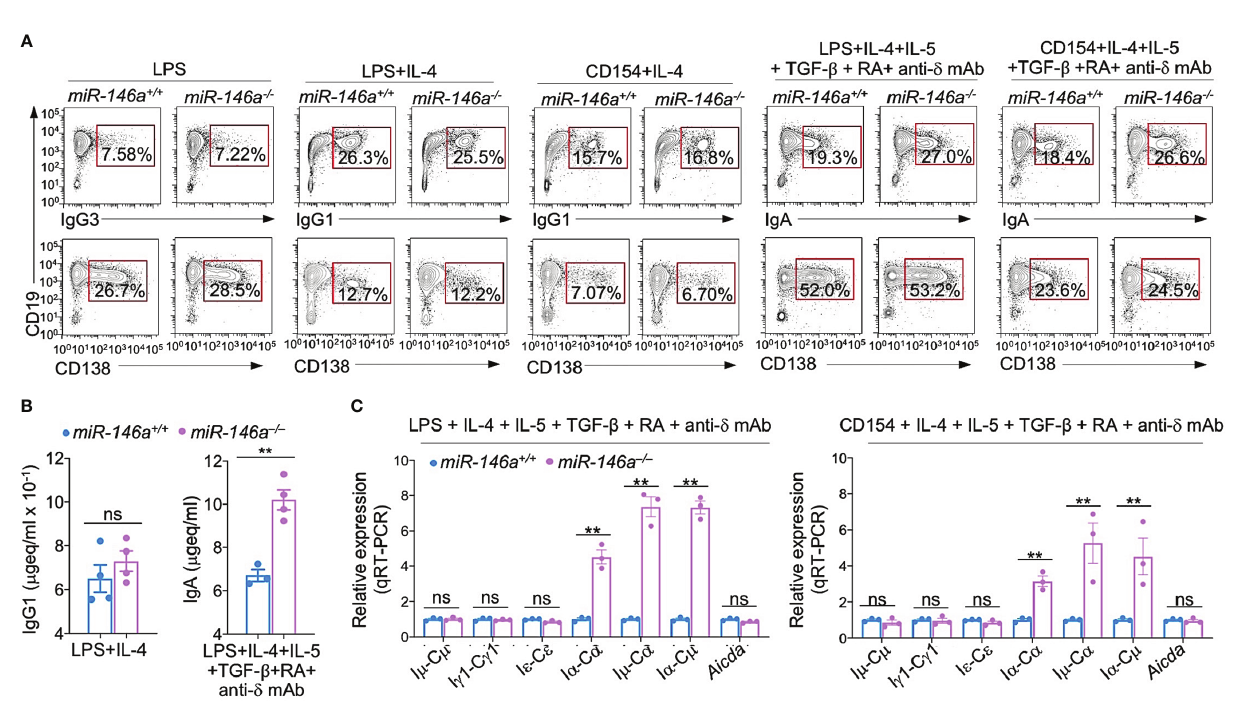
FIGURE 5 | miR-146a ablation results in increased germline I a -C a transcripts and enhanced CSR to IgA . (A) miR-146a – / – and miR-146a +/+ B cells were stimulated with LPS, LPS or CD154 plus IL-4, LPS or CD154 plus IL-4, IL-5, TGF- b , RA and anti- d mAb, and cultured for 96 h. IgG1 + , IgG3 + and IgA + B cells and CD138 + plasma cells as analyzed by fl ow cytometry. Data are one representative of three independent experiments yielding similar results. (B) IgG1 and IgA concentrations in culture fl uids from 146a – / – and miR-146a +/+ B cells stimulated by LPS plus IL-4 or LPS plus IL-4, IL-5, TGF- b , RA and anti- d mAb, as measured by ELISA. (C) miR- 146a – / – and miR-146a +/+ B cells were stimulated by LPS or CD154 plus IL-4, IL-5, TGF- b , anti- d mAb and RA, and cultured for 72 h. Expression of germline I m -C m , I g 1-C g 1 , I a -C a and I ϵ -C ϵ transcripts, circle I a -C m and post-recombination I m -C a transcripts, as well as Aicda transcripts as analyzed by qRT-PCR and normalized to b -Actin. Data are ratios to miR-146a +/+ B cells (set as 1; means±SEM of three independent experiments). ** p < 0.01, ns, not signi fi cant, paired t